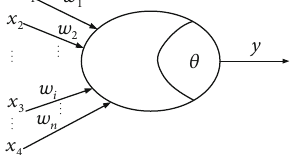
Figure 5: The model of arti fi cial